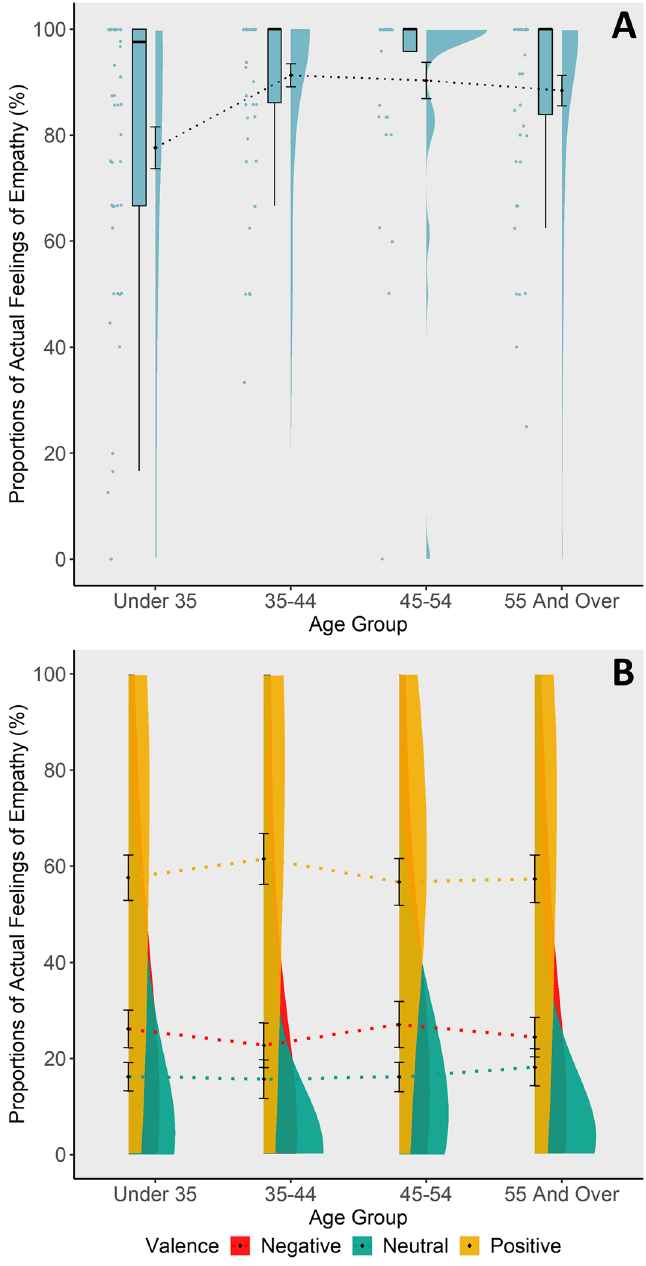
Figure 2. Daily empathy. The y-axis shows the proportions of answering ‘yes’ when asked about the actual feelings of empathy relative to the total amount of answered surveys. ( A ) Adult age differences regarding actual feelings of empathy. Significant quadratic association of actual feelings of empathy and age. ( B ) Interaction between valence (negative, neutral, or positive target emotion) of the empathy opportunity and age on reported feelings of daily empathy. Age did not moderate the link between the valence of the situation and actual feelings of